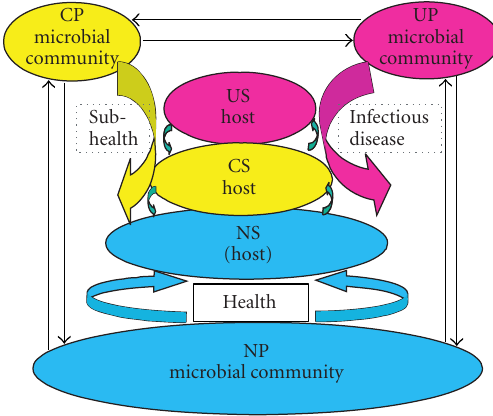
Figure 1: Schematic representation of interactions of three mi- crobial communities (nonpathogenic (NP), conditional pathogenic (CP), and unconditional pathogenic (UP)) with the hosts at three di ff erent health statuses (nonsusceptibility (NS), conditional sus- ceptibility (CS), and unconditional susceptibility